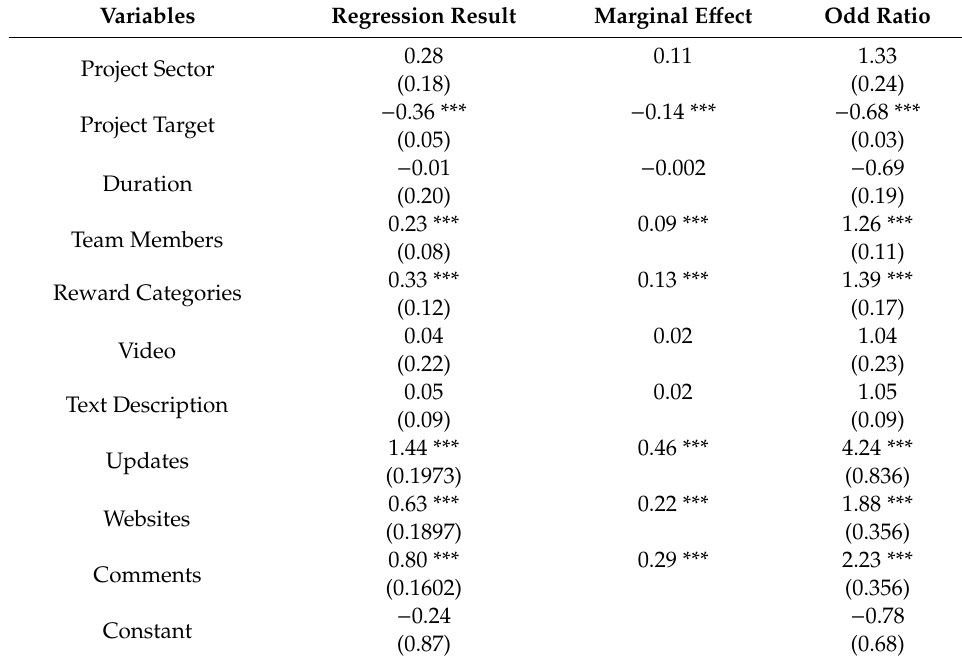
Table 6. Regression, marginal e ff ect, and odds ratio